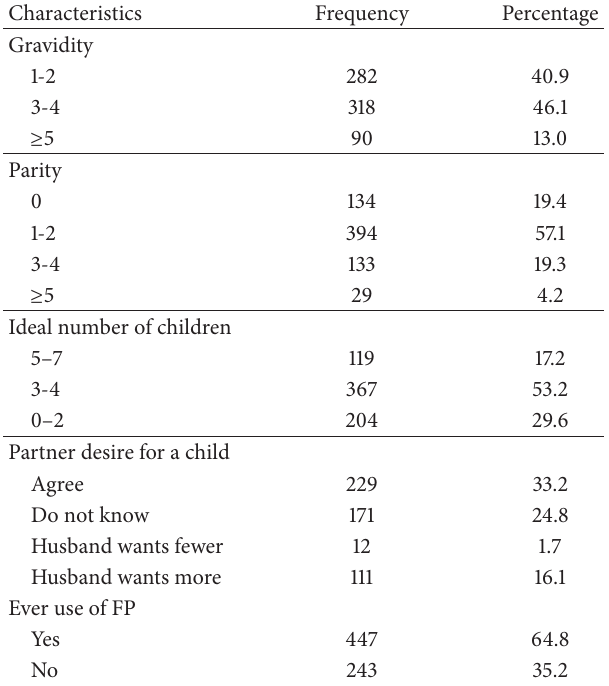
Table 2: Reproductive and contraceptive utilization characteristics of participants ( 𝑛 = 690